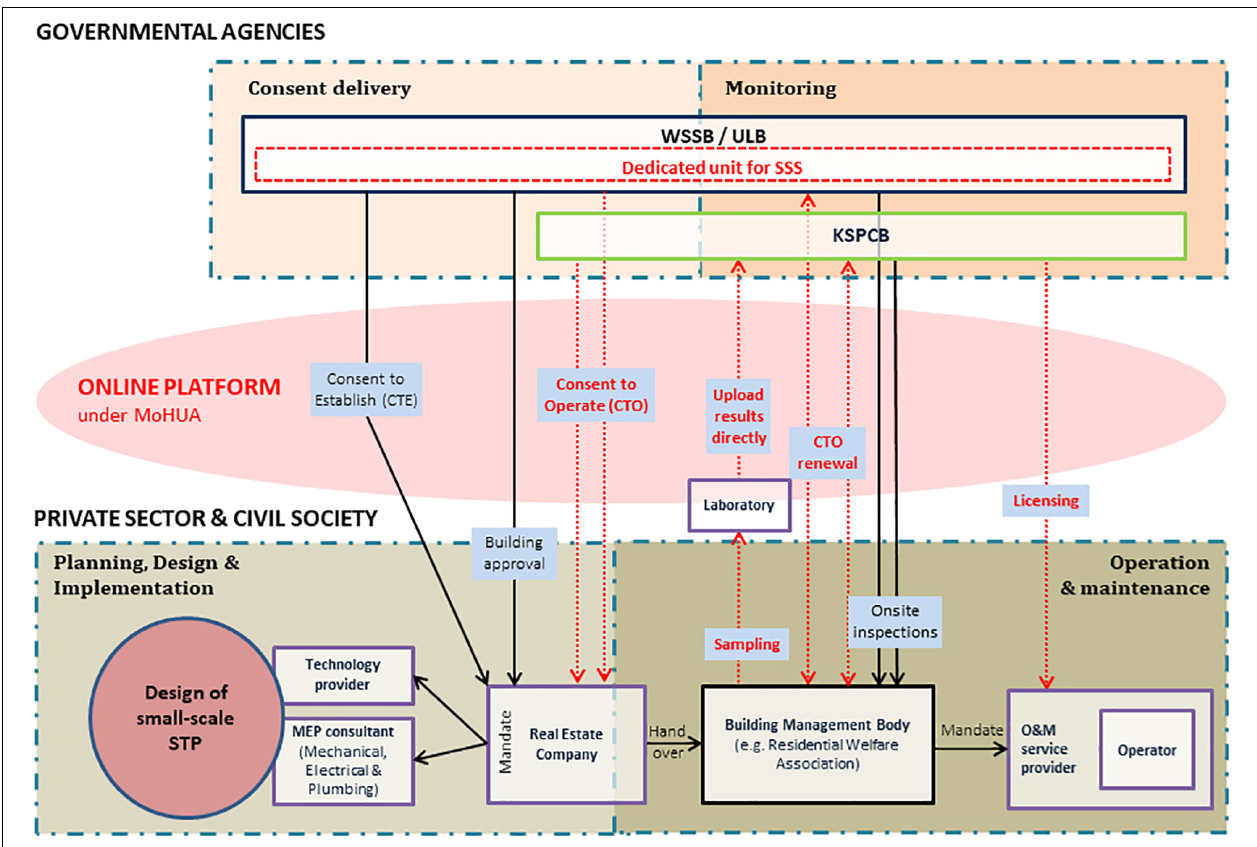
FIGURE 4 | New governance arrangements and streamlined procedures proposed by the authors (in red